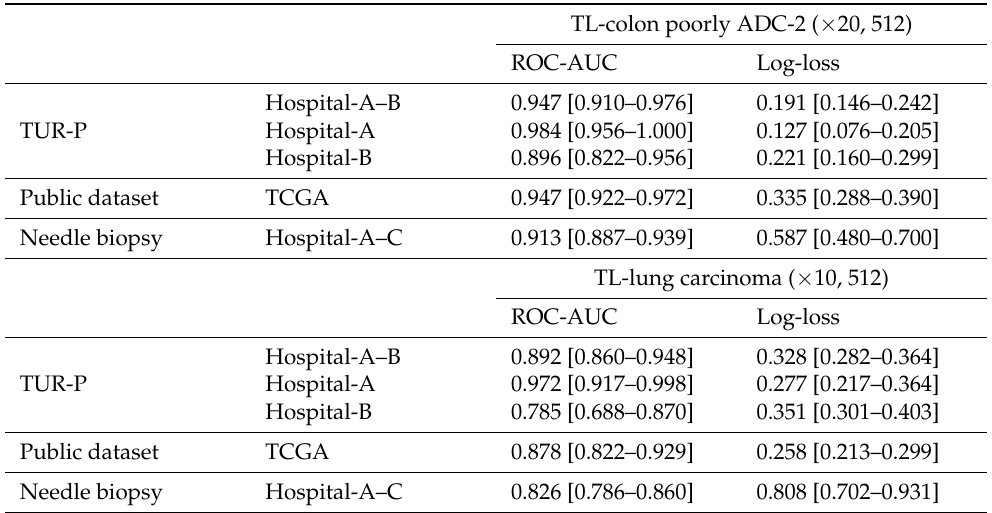
Table 4. ROC-AUC and log loss results for adenocarcinoma classification on the transuretheral resec- tion of the prostate (TUR-P), public dataset (TCGA), and needle biopsy test sets using trained